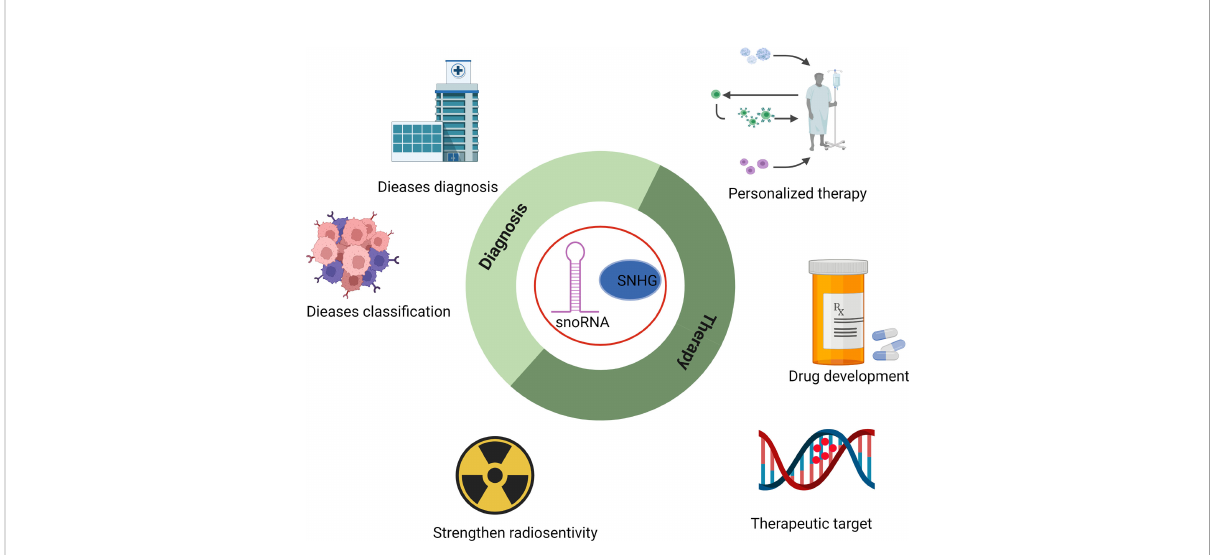
FIGURE 3 Potential application of snoRNAs in the diagnosis, classi fi cation, strengthening radiosensitivity, drug development, and personalized therapy of hematopoietic